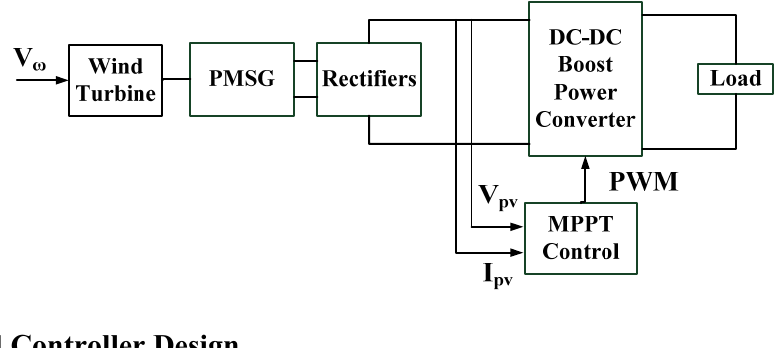
Figure 3. Wind power system structure. PMSG: permanent magnet synchronous generator; DC: direct current; PWM: pulse width modulation; and MPPT: maximum power point tracking.